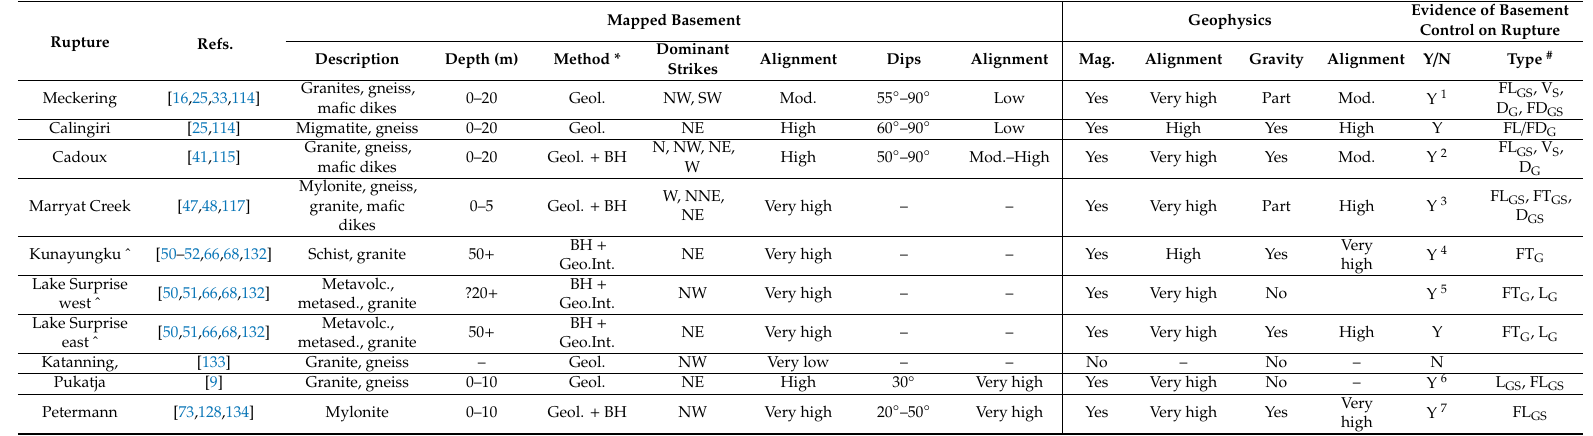
Table 4. Degree of alignment between rupture, basement structures, and geophysical